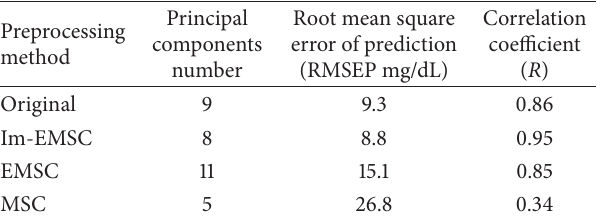
Table1:Predictionresultsofthetestsetwithdifferentpreprocessing